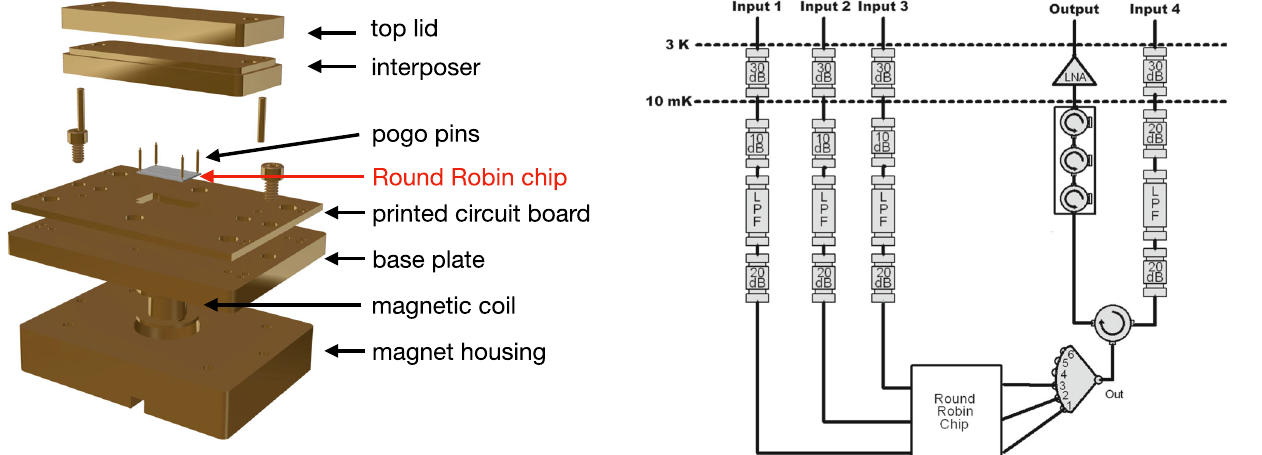
Fig. 1 Round Robin chip (gray) enclosed in its gold-plated copper box hosting the printed circuit board